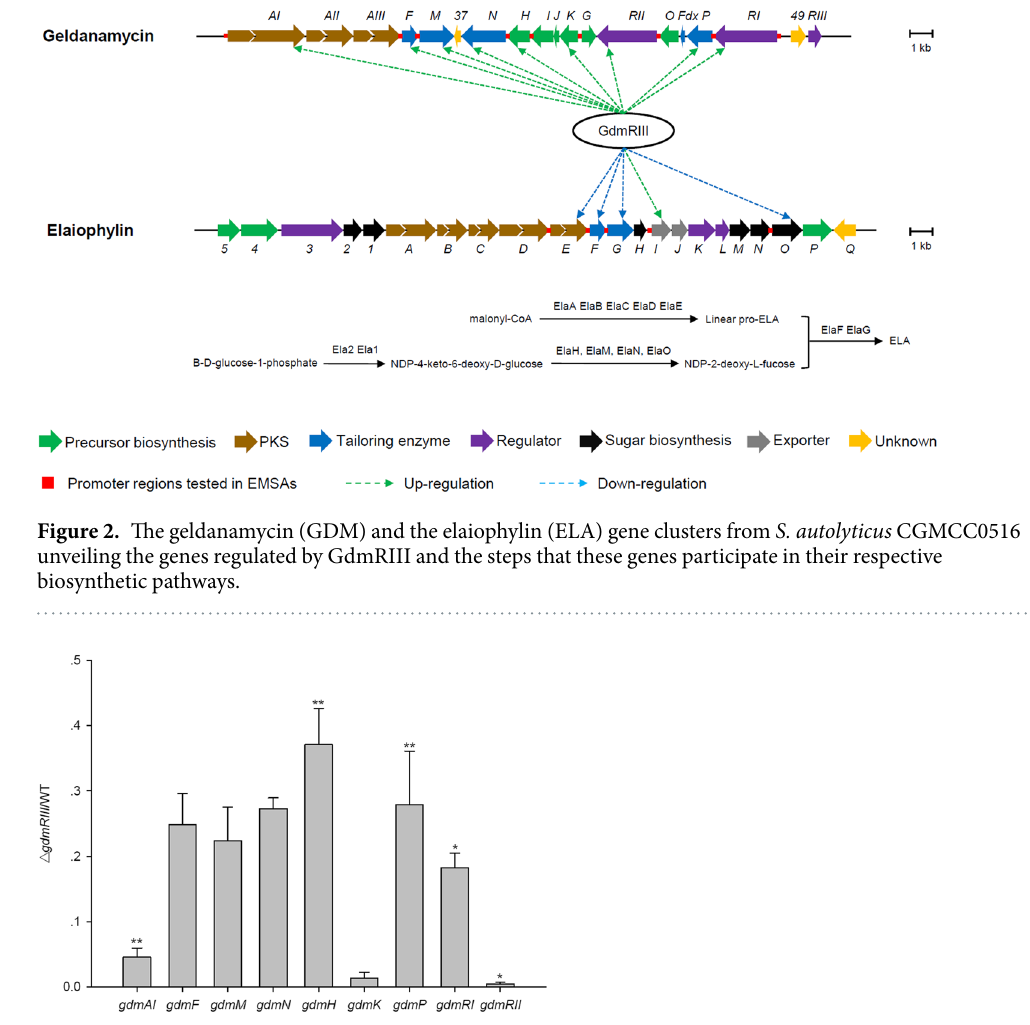
Figure 3. Analyses of the transcriptional levels of genes in the geldanamycin biosynthetic gene cluster. Values are the average of three independent experiments, each with three replicates. Error bars indicate the standard deviation of means. * p < 0.05, ** p < 0.01 by paired samples